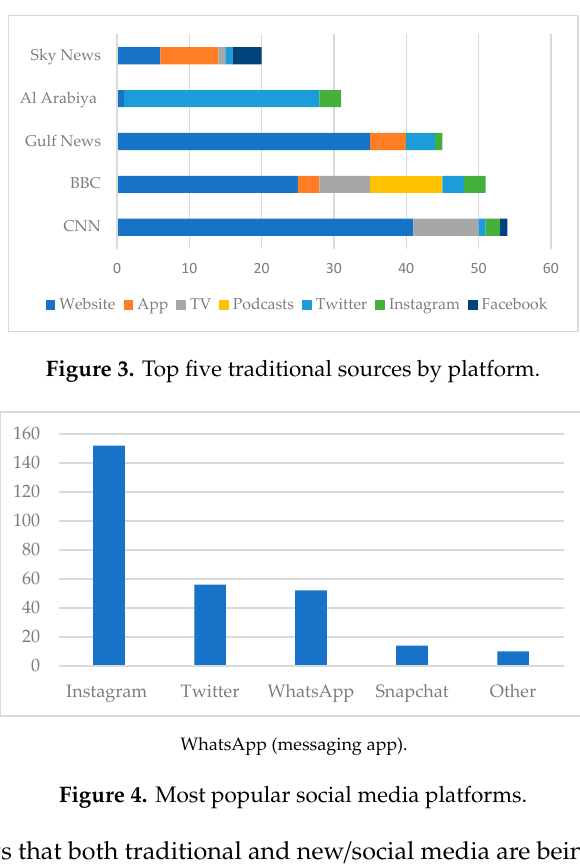
Table 3. Device use (primary and secondary).